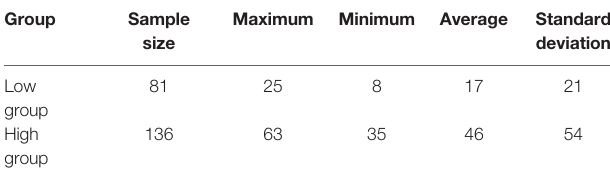
TABLE 1 | Phenotypic statistics.